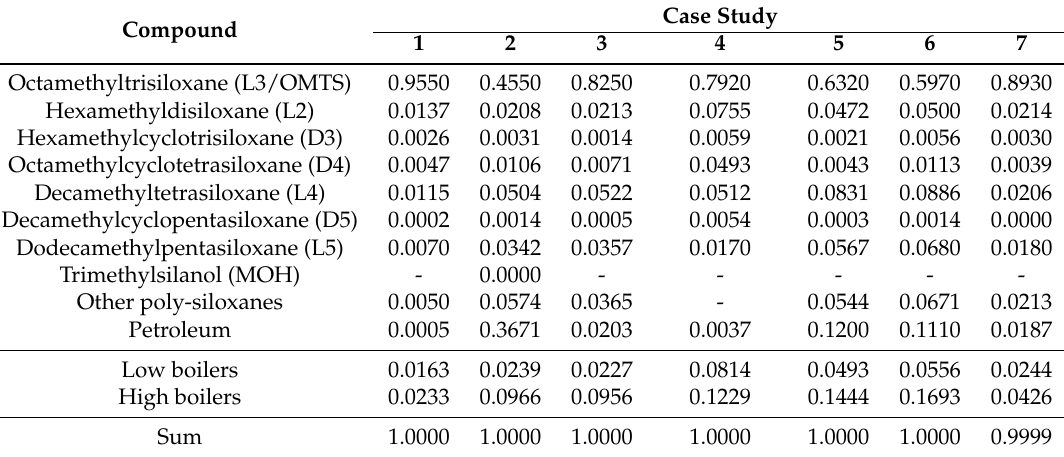
Table A1. Detailed working fluid compositions of case Studies #1–#7.